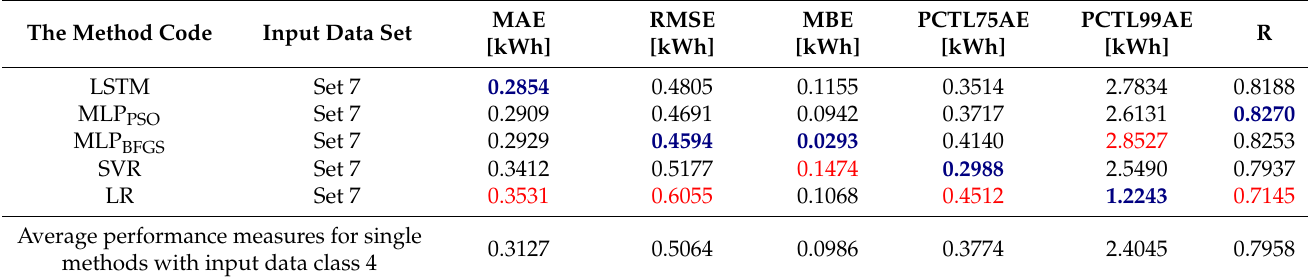
Table 10. Performance measures for single methods with input data class 4.